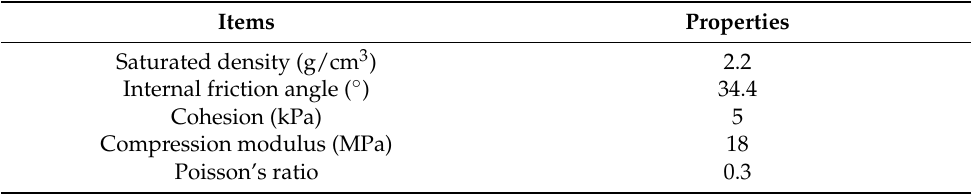
Table 1. Geotechnical properties of tested